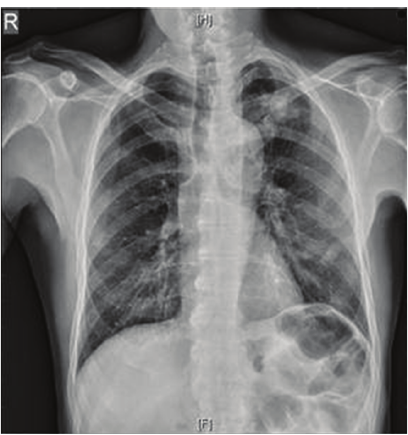
Figure 1: A cavity in the left upper zone of the left lung.